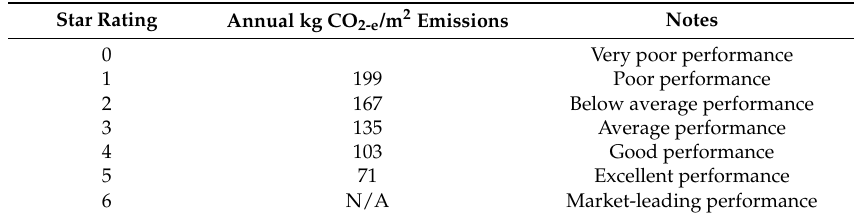
Table 1. National Australian Built Environment Rating System (NABERS) scheme star rating assessment in relation to CO 2 -e emissions